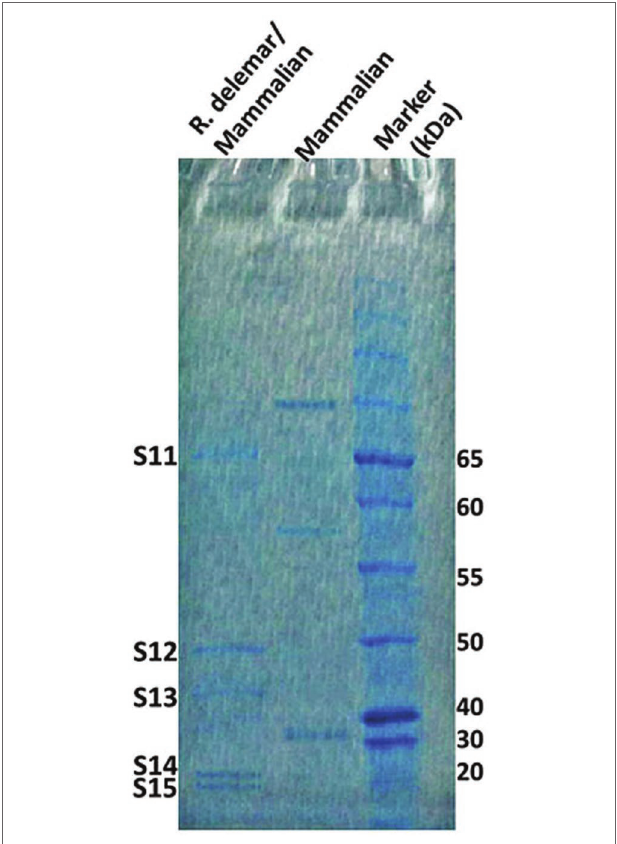
FIGURE 1 | R. arrhizus var. delemar secretome analysis in relation to initiation of infection. SDS gel electrophoresis of culture supernatants collected from mammalian cell cultures and co-cultures of R. arrhizus var. delemar and lung epithelial cells.